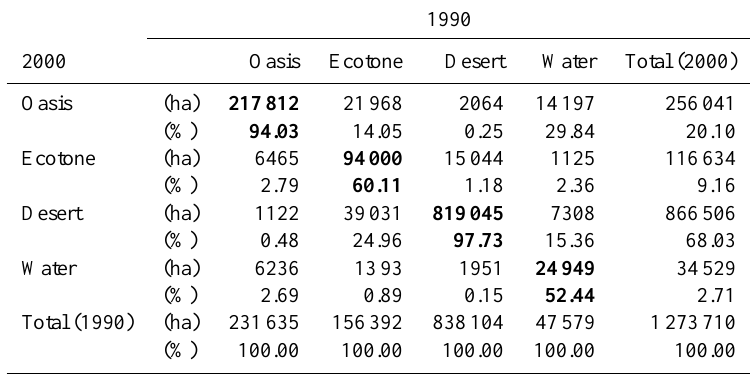
Table 4. The conversion (change) matrix of land cover change from 1990 to 2000 ∗ .